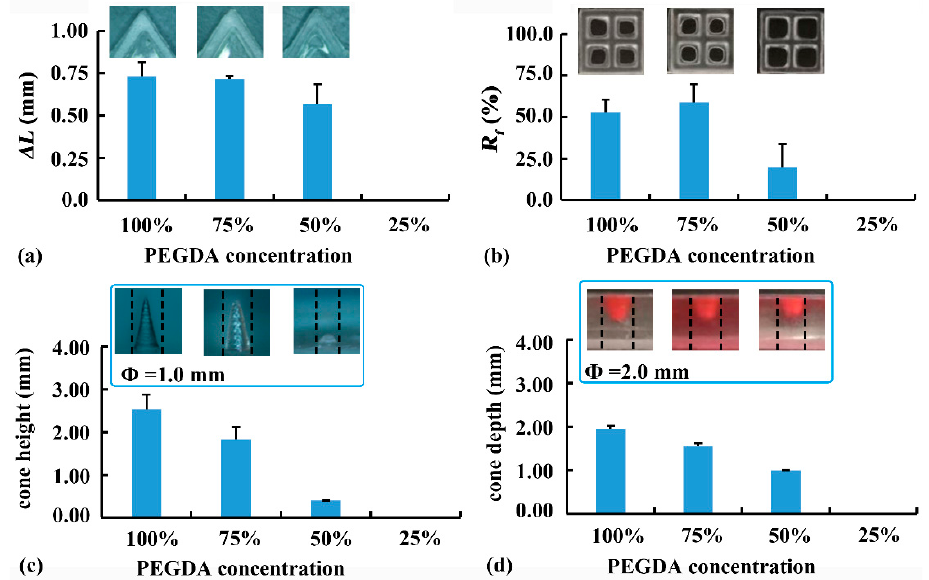
Figure 5. Effect of poly(ethylene glycol) diacrylate (PEGDA) concentration on the printability: ( a ) inner arc length ( Δ L ) and ( b ) cavity fusion rate ( R f ) of 2D samples; and ( c ) cone height and ( d ) cone depth of 3D samples.